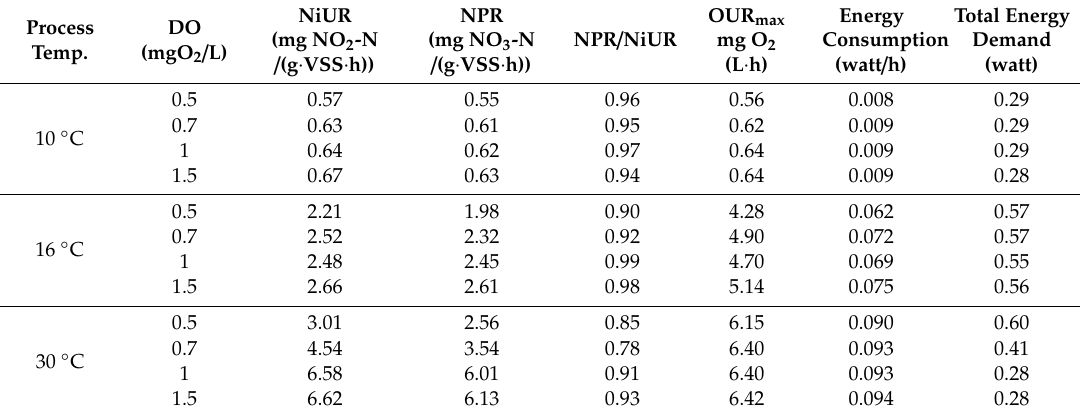
Table 3. Summary of the main criteria for the evaluation of the nitrification process based on the AOB-NOB activity at di ff erent temperatures and DO concentrations with nitrite as a sole nitrogen source (substrate limiting conditions for NOB). Process